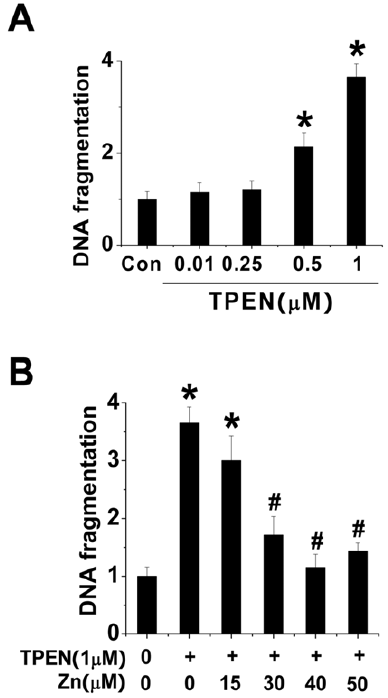
Figure 7. TPEN induced apoptosis in HepG2 cells is prevented by supplementation of Zn. HepG2 cells were treated by indicated concentrations of TPEN for 30 h and then the cell death was detected by DNA fragmentation assay (A). HepG2 cells were also treated with 1 m M TPEN in the absence or presence of Zn at indicated concentra- tions for 30 h and then the cell death was detected by DNA fragmentation assay (B). Experiments were repeated three times at least and the data are presented as mean 6 SD. * P , 0.05 vs. control group; # P , 0.05 vs. TPEN group.